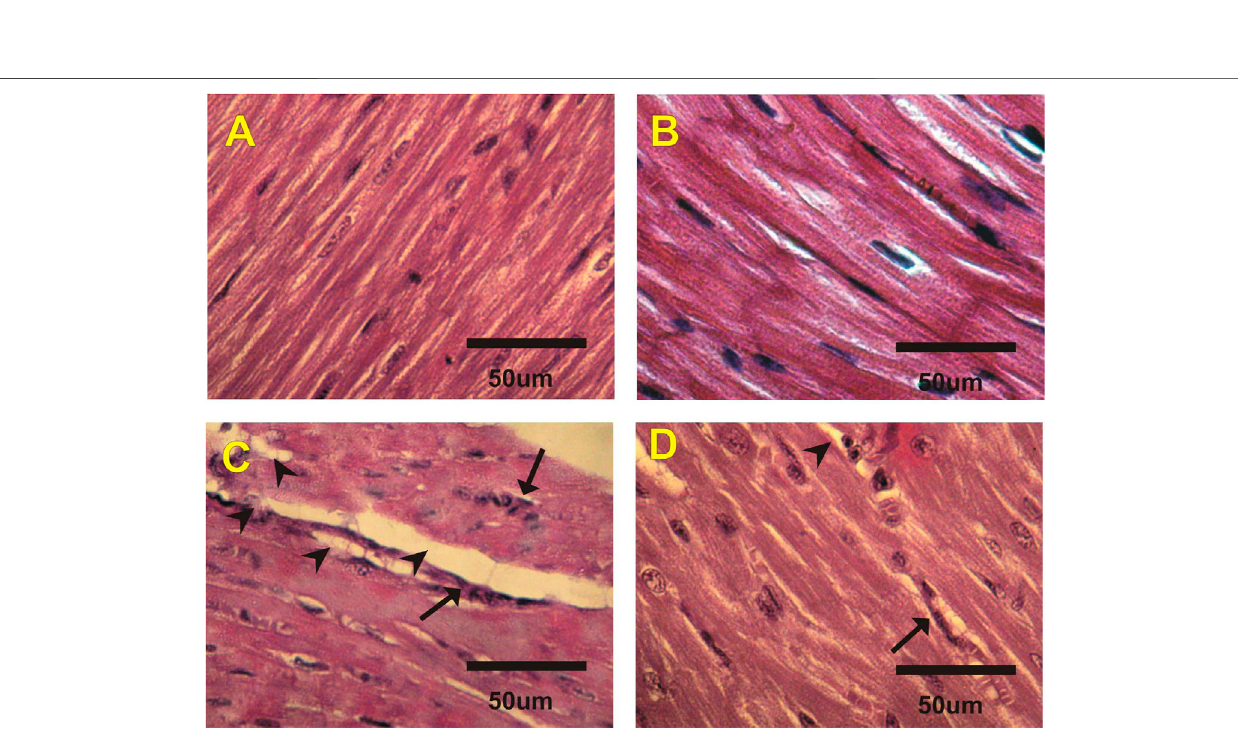
FIGURE 2 | Photomicrographs of heart sections from different experimental groups stained with H&E. The (A) control (G1) and (B) costus (G2) groups show a normal myo fi brillar structure with striations. (C) The EST group (G3) shows moderate myocardial atrophy and leukocyte in fi ltration (arrows). (D) The EST group treated with costus (G4) shows mild myocardial atrophy. H and E, hematoxylin and eosin; EST, Ehrlich solid tumor.